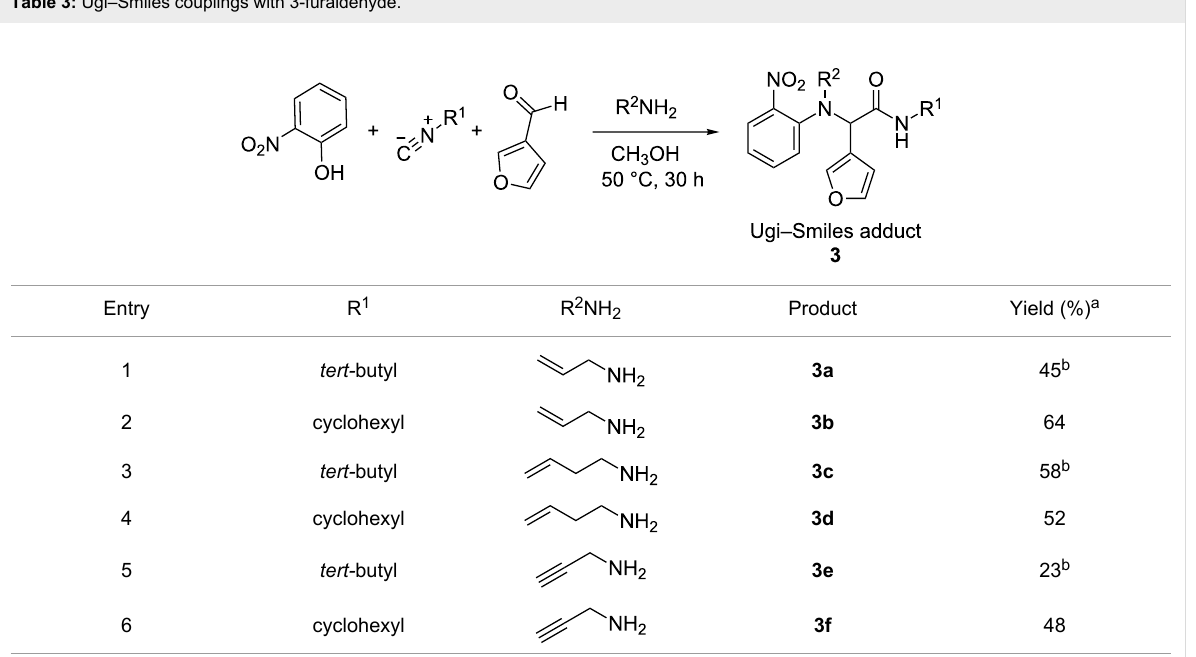
Table 3: Ugi–Smiles couplings with